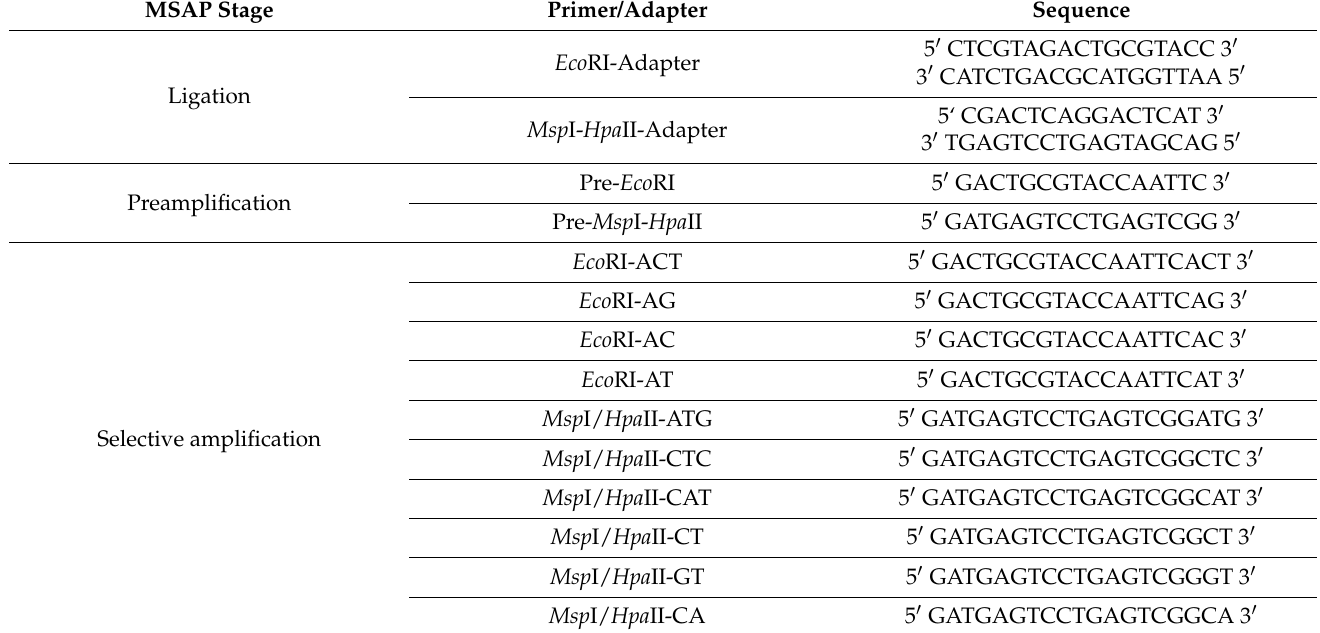
Table 1. Sequences of adapters and primers used for MSAP